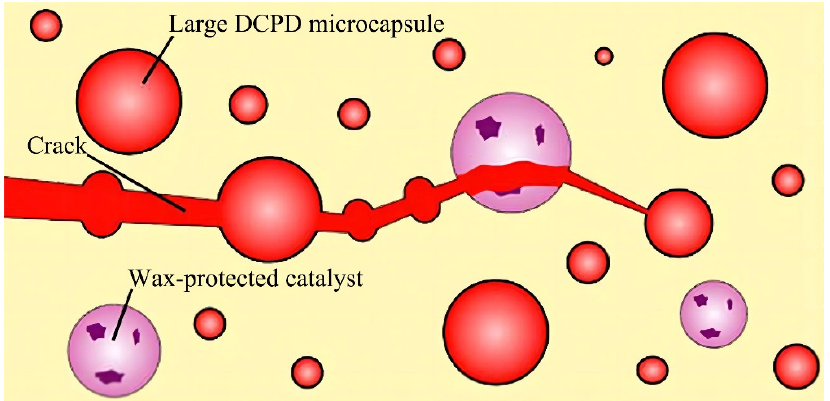
6 of 24 Figure 3. Crack-healing mechanism in ceramics [45]. Based on the application of lightweight composite material components in aero-en- gines, the self-healing materials in MoSi 2 , CrMoSi and CrSi 2 have been investigated [46].